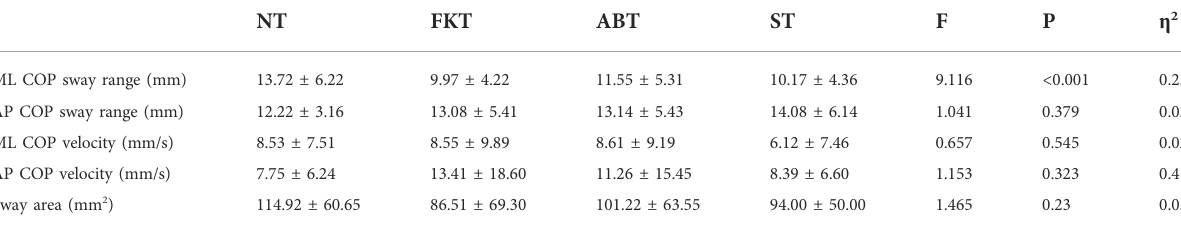
TABLE 2 Comparison of parameters in COP for different